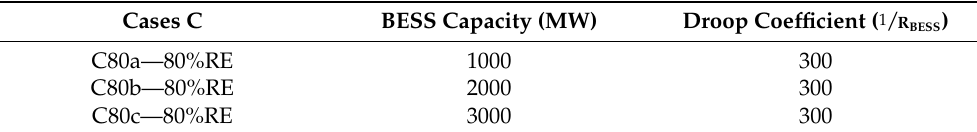
Table 7. Group C, different BESS capacity, fixed droop coefficient, A80—80% RE penetration.